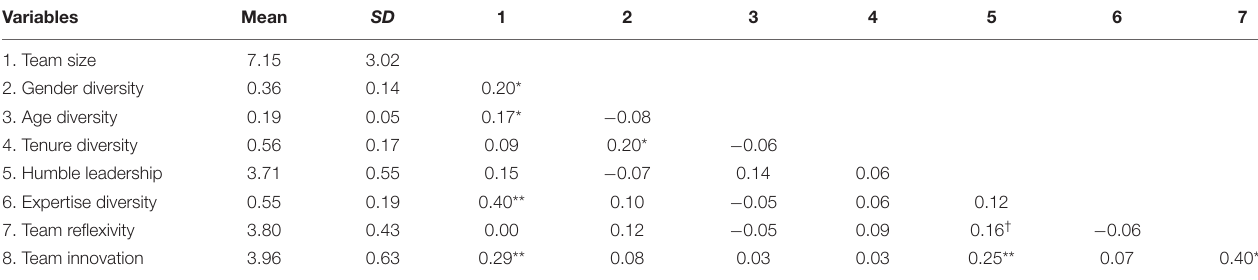
TABLE 1 | Descriptive statistics and bivariate correlations.